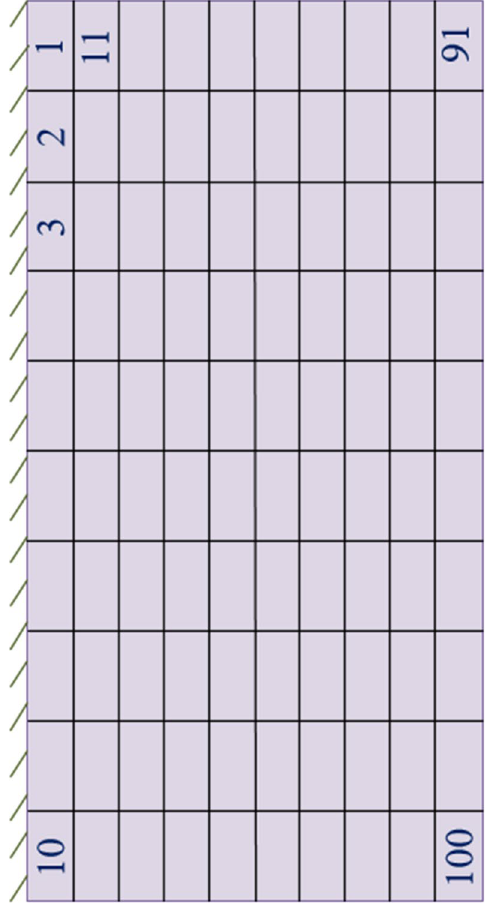
Figure 13. Cantilever smart plate having 100 elements.